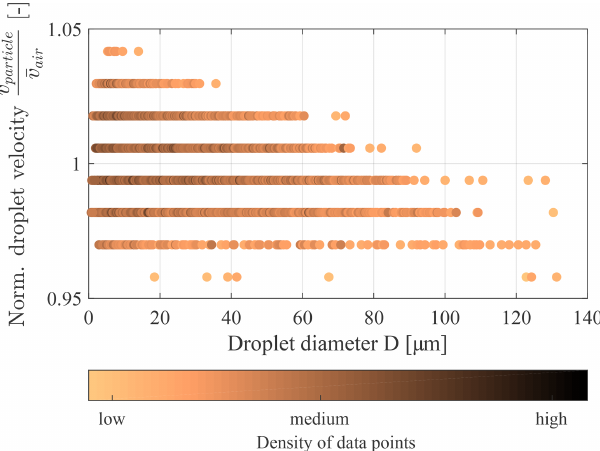
Figure 3. Droplet diameter histogram and cumulative volume curve at 20ms − 1 (PDI run 18 April 2019